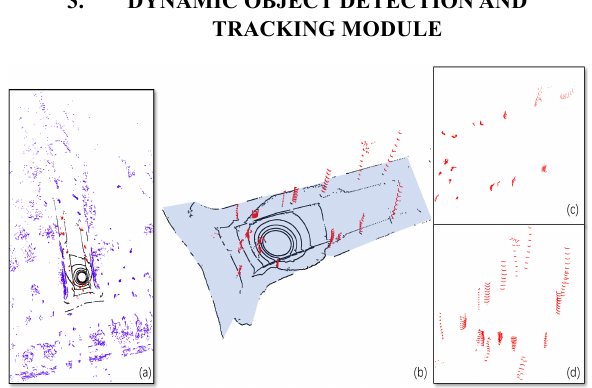
Figure 2. Point cloud selection with black as ground, blue as non-ground and red as interested part. (a) orginal laser scan; (b) convex hull region shaded; (c) top-down view; (d) side view.